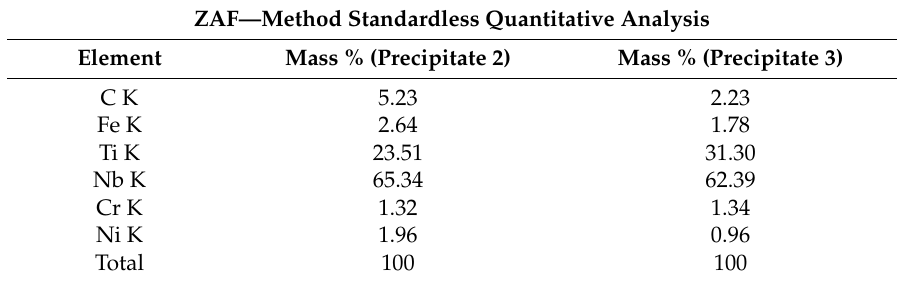
Both precipitates are quite similar for this alloy, possibly (Nb,Ti)C